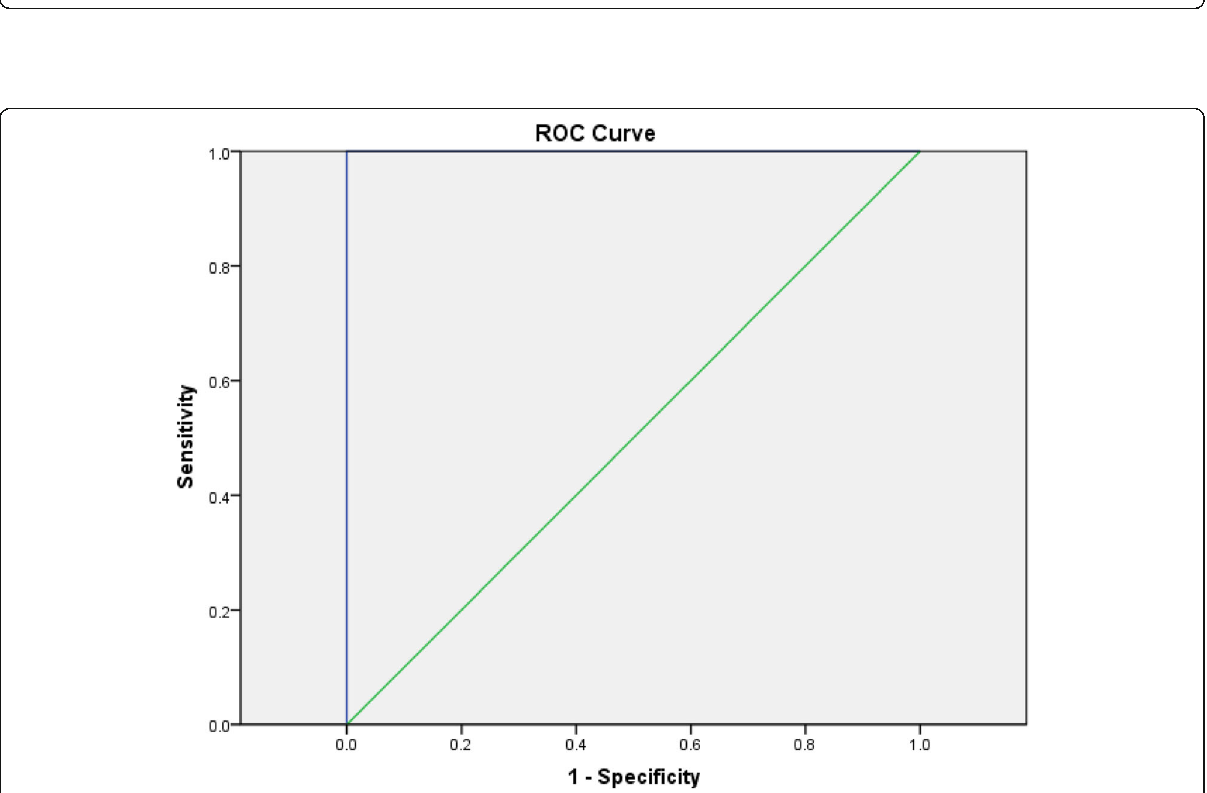
Fig. 3 Receiver-operating characteristic (ROC) curve for uterine arteries systolic/diastolic ratios in discrimination of the unexplained infertility group and the fertile control